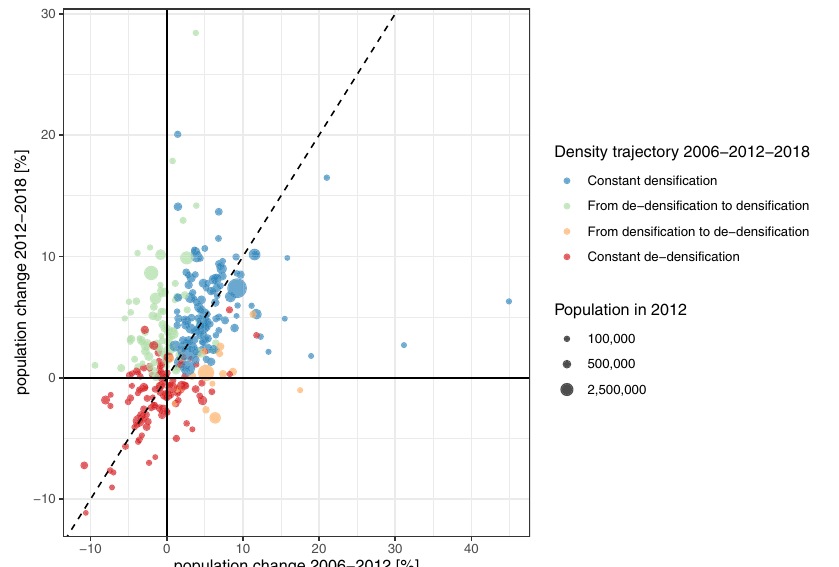
Fig. 7 Population changes associated to different density trajectories. The location of the point in the graph indicates the relationship between population changes in the fi rst (2006 – 2012) and in the second period (2012 – 2018). The diagonal line indicates equal population change in both periods. Points below the line correspond to cities with a greater increase (or a smaller decrease) in population in the fi rst period, points above the line correspond to cities with a greater increase (or a smaller decrease) in population in the second period. The further the location of the point from the diagonal line, the greater the difference in population change between the two